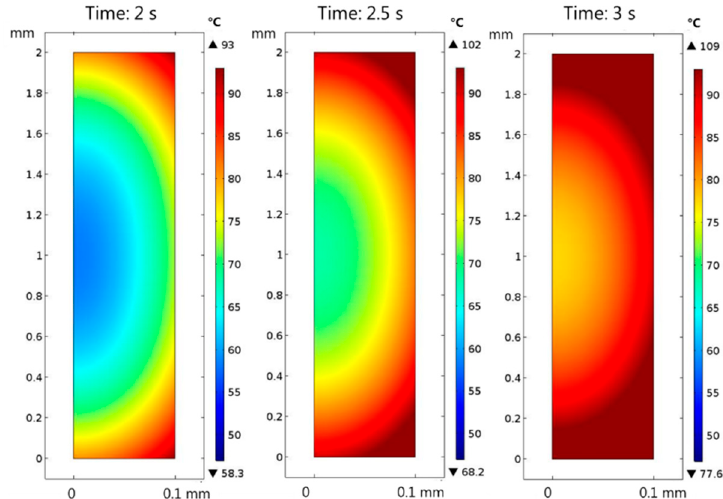
Figure 5. Simulated temperatures in a model seed exposed to a gas temperature of 200 °C and a gas velocity of 0.08 m s − 1 for 2 s, 2.5 s, and 3 s.